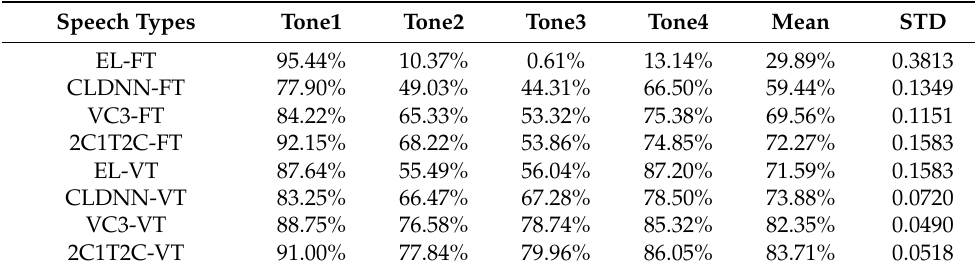
Table 5. The tone accuracy of unenhanced/enhanced continuous Mandarin EL speech. Speech